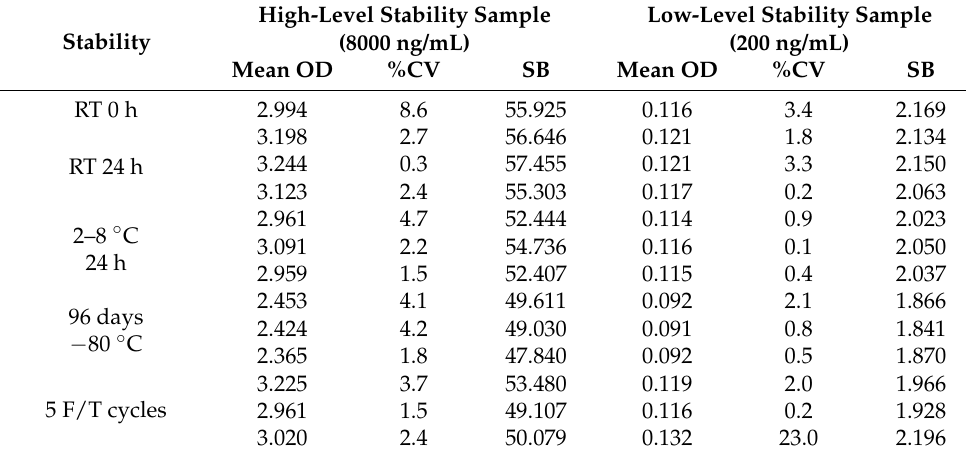
Table 5. Stability of anti-GQ1001 antibodies stored at different conditions (including F/T treatment).